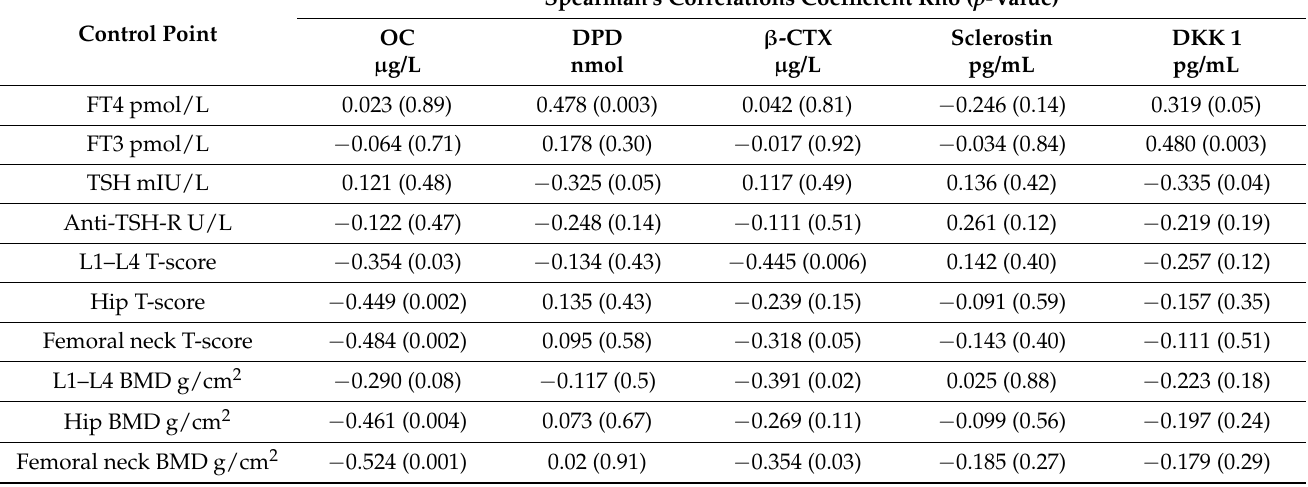
Table 7. Association of thyroid hormones, TSH, anti-TSH-R, and DXA findings with markers of bone turnover and Wnt inhibitors on control measurement at control